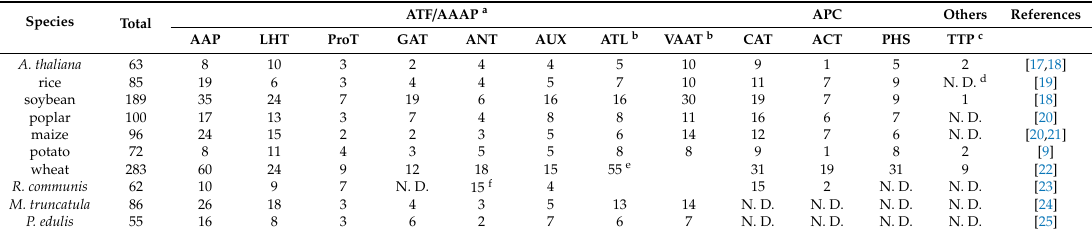
Table 1. Number of amino acid transporter family (ATF) and amino acid-polyamine-choline transporter (APC) family members in some plant